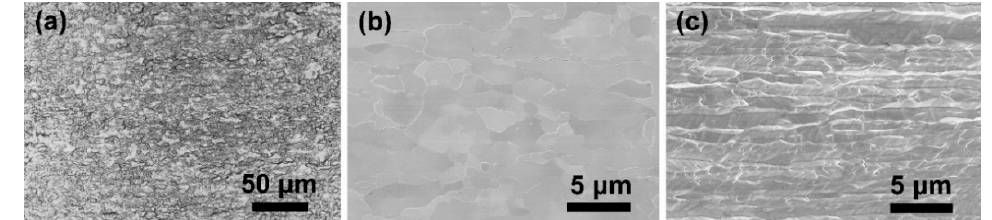
Figure 5. The microstructure of the original W foil. ( a ) Metallographic structure of the etched rolling surface, and SEM microstructure of ( b ) the rolling surface and ( c ) the side surface.